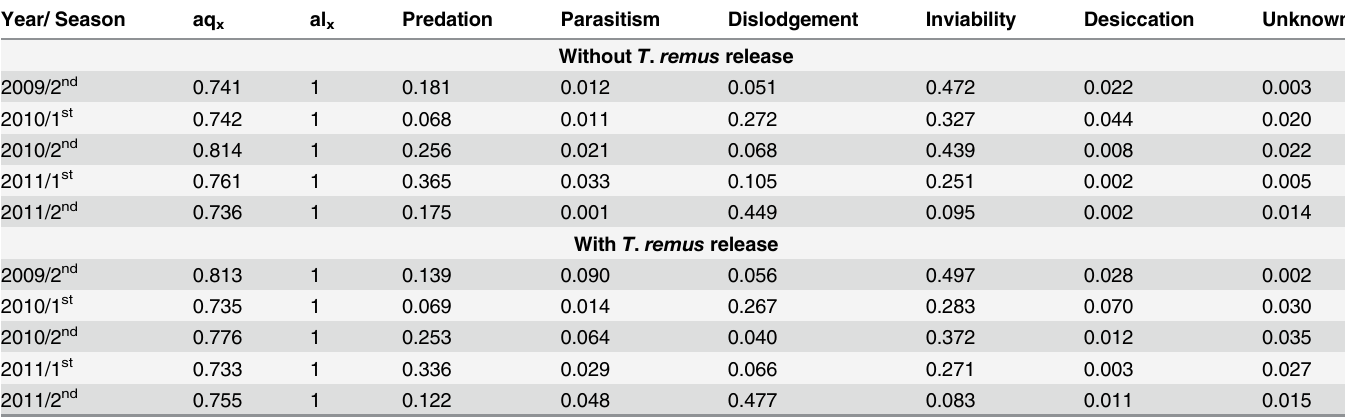
Table 2. Multiple decrement life table for egg stage of FAW in maize fields with and without Telenomus remus releases. Year/ Season aq x al